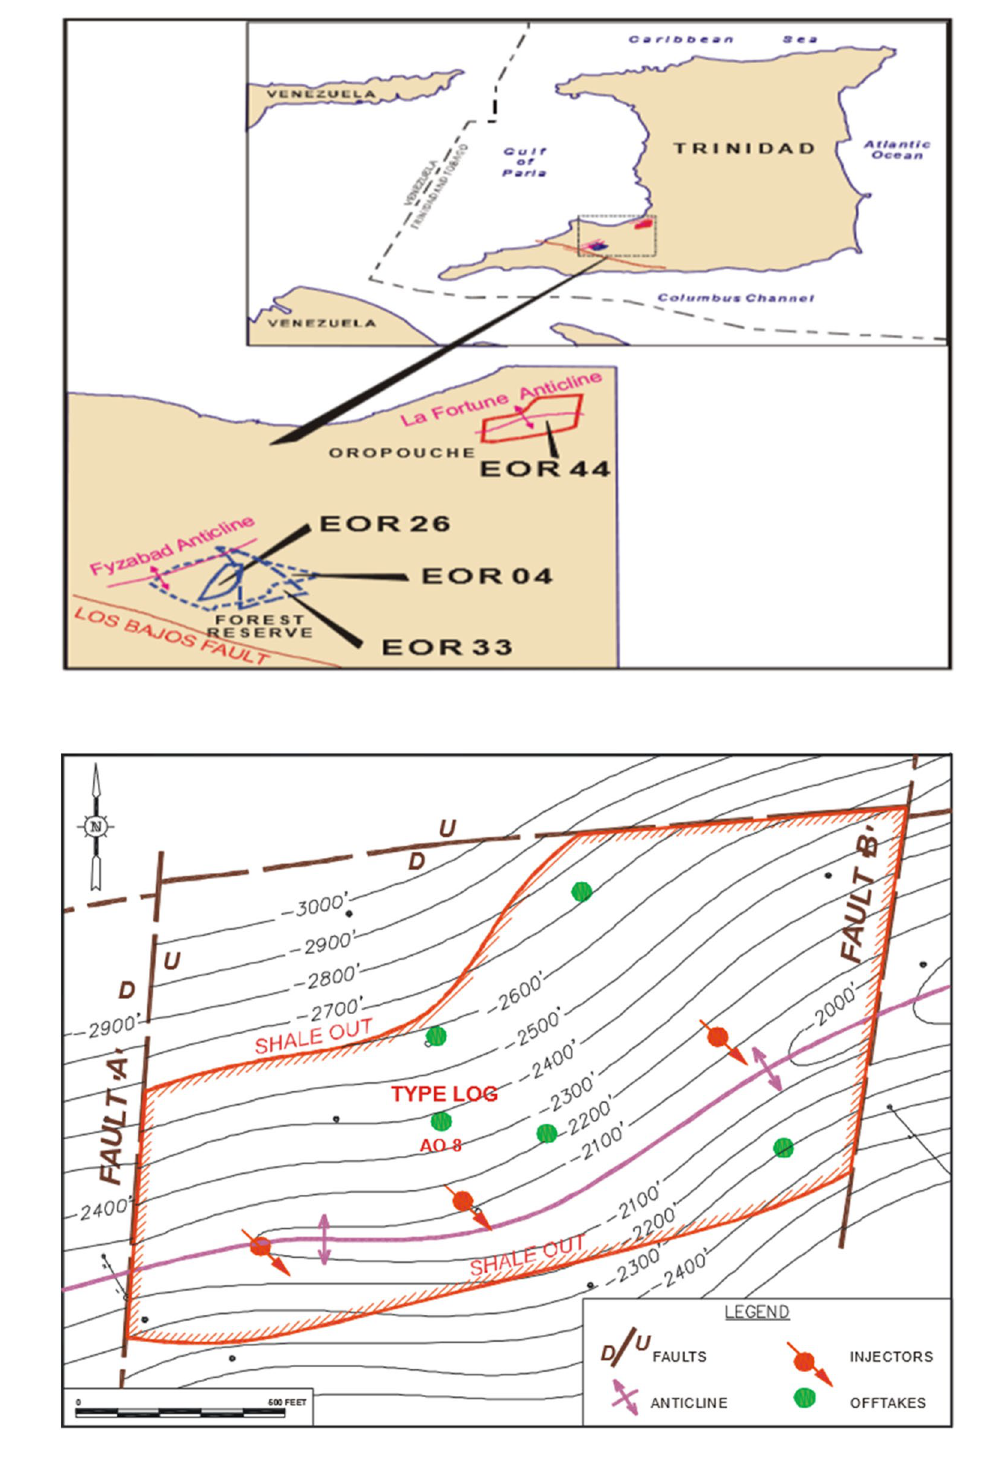
Fig. 2 Location of EOR 44 in Trinidad (Mohammad-Singh and Singhal 2004)